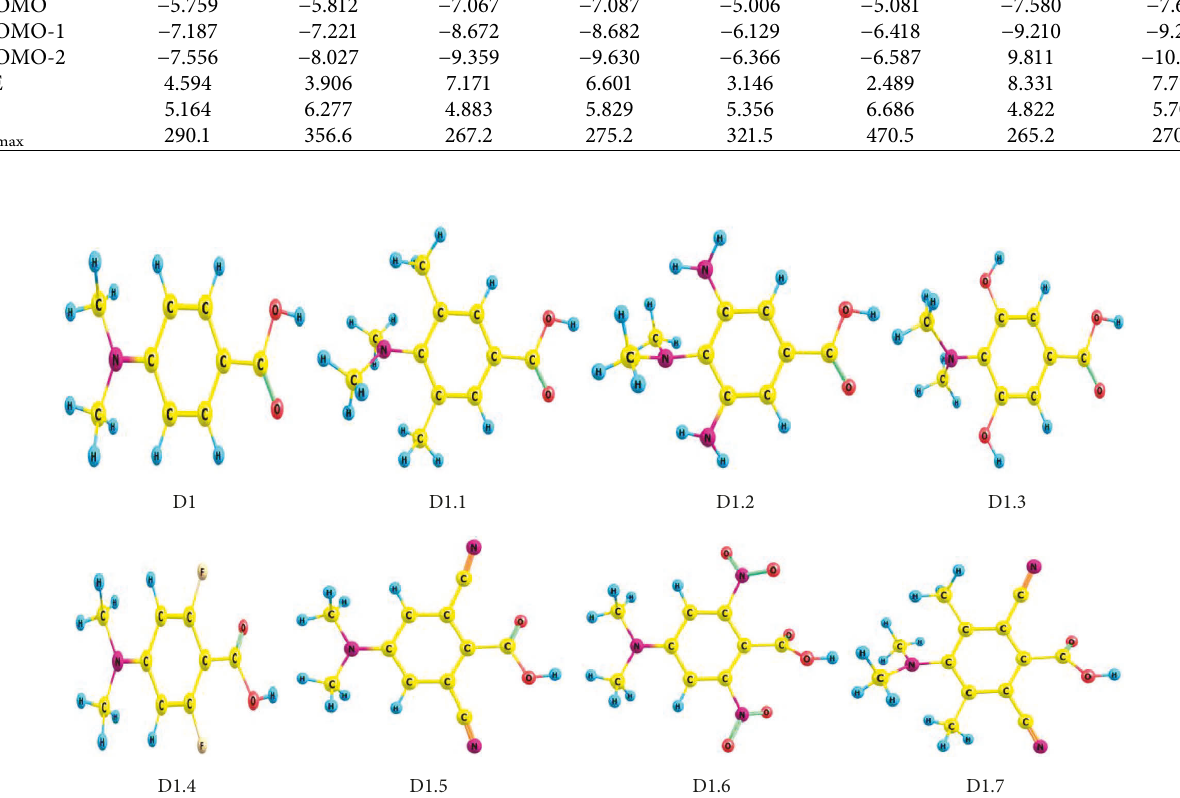
Figure 3: The optimized geometrical structures of 4-DMABA derivatives (D1-D1.7) have been obtained by using the B3LYP/6-311++G ∗∗ level of